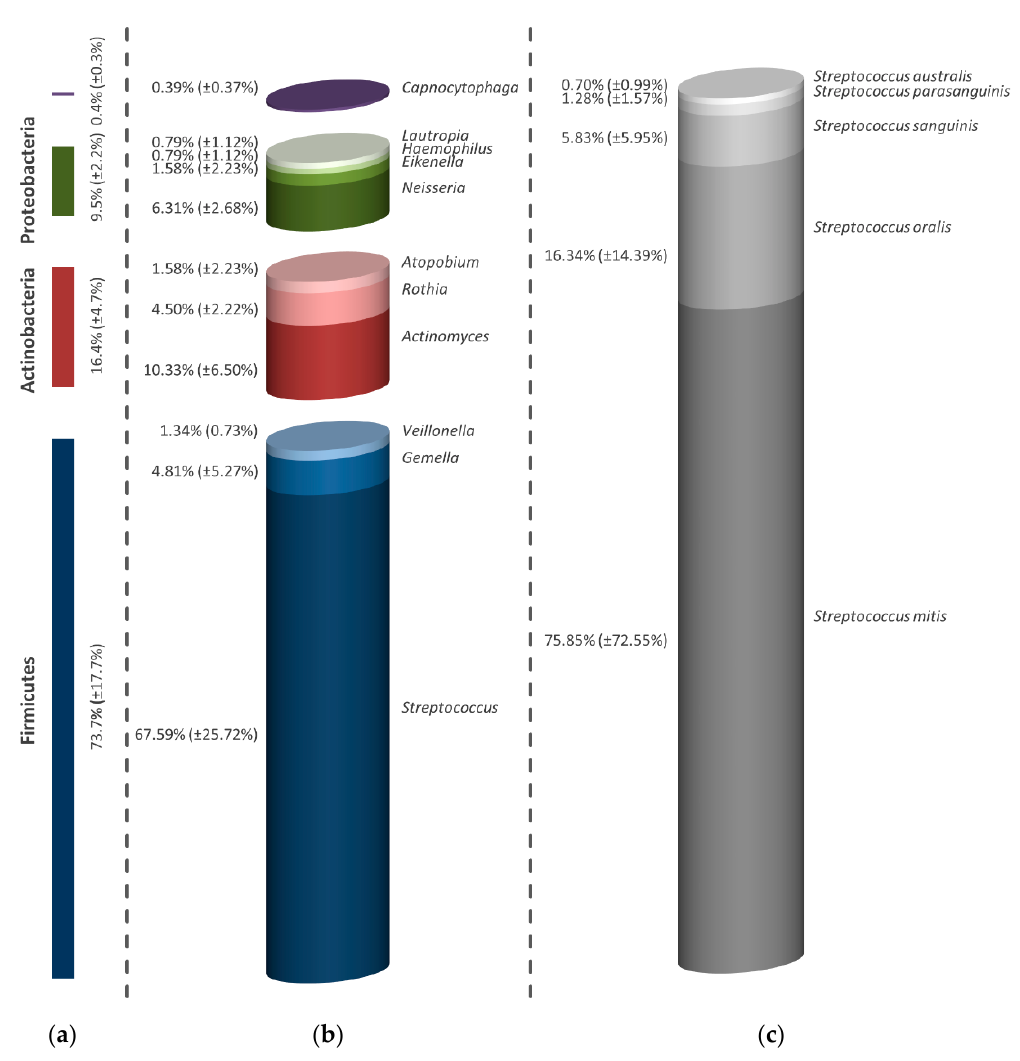
Figure 1. Column diagrams of the different microorganisms of the initial biofilm in the untreated control. The composition is shown in strain ( a ), genus ( b ) and bacterial species within the highest genus ( c ). All percentages given refer to all examined subjects. The bars depict the average values in percentage of three discs (one from each volunteer). In addition to the average values, the standard deviations are also presented in parentheses.